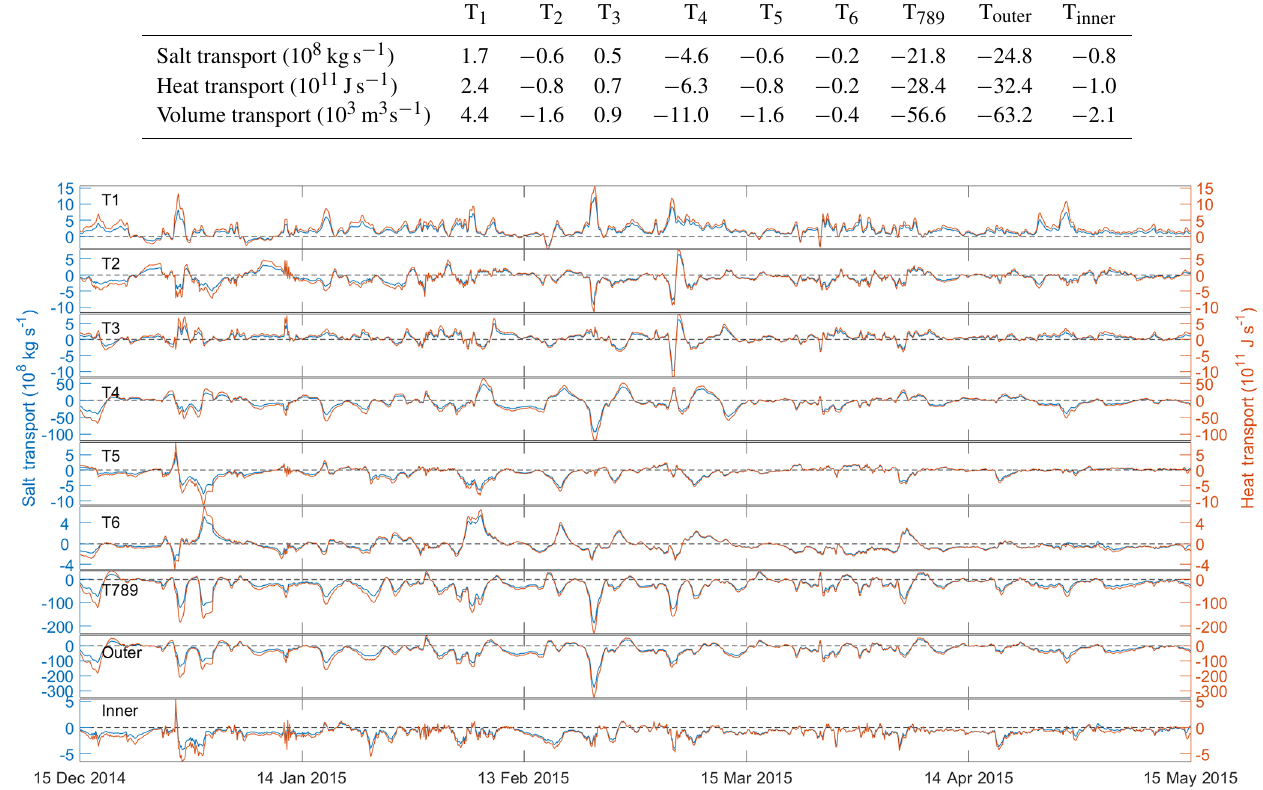
Figure 14. Time series of heat and salt transports normal to and integrated over transects T1 to T789 between 15 December 2014 and 15 May 2015. Transports across the outer (T1 + T2 + T3 + T4 + T789) and inner (T5 + T6) domains are plotted too.